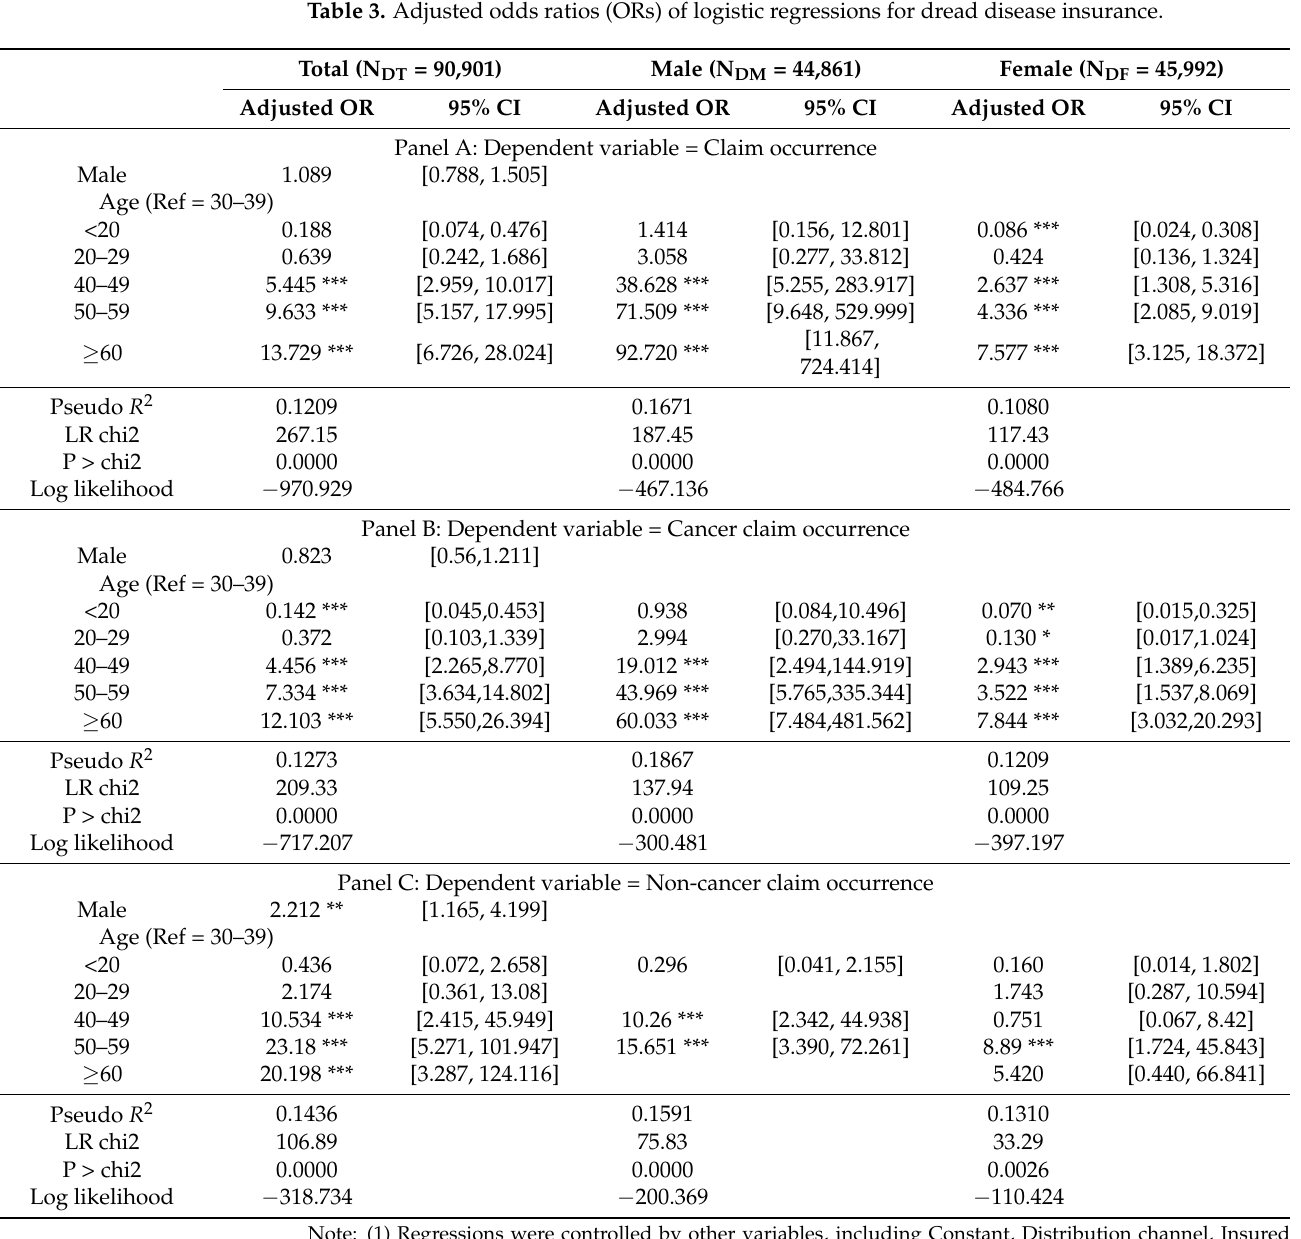
Table 3. Adjusted odds ratios (ORs) of logistic regressions for dread disease